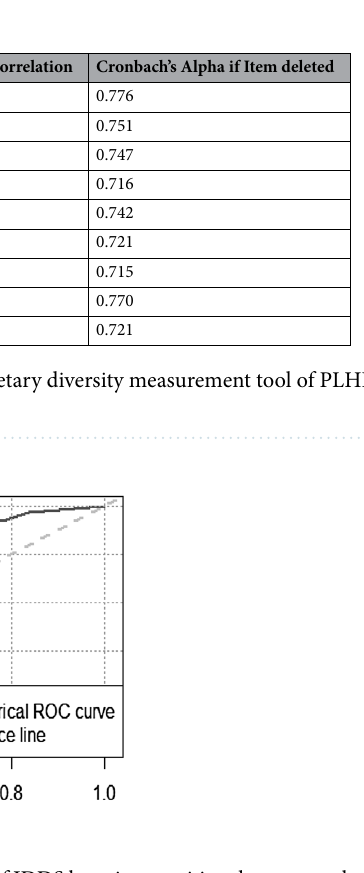
Figure 3. Receiver operating characteristic curve of IDDS by using nutritional status as a benchmark of PLHIV in all Bahir Dar ART clinics, 2017 42 .